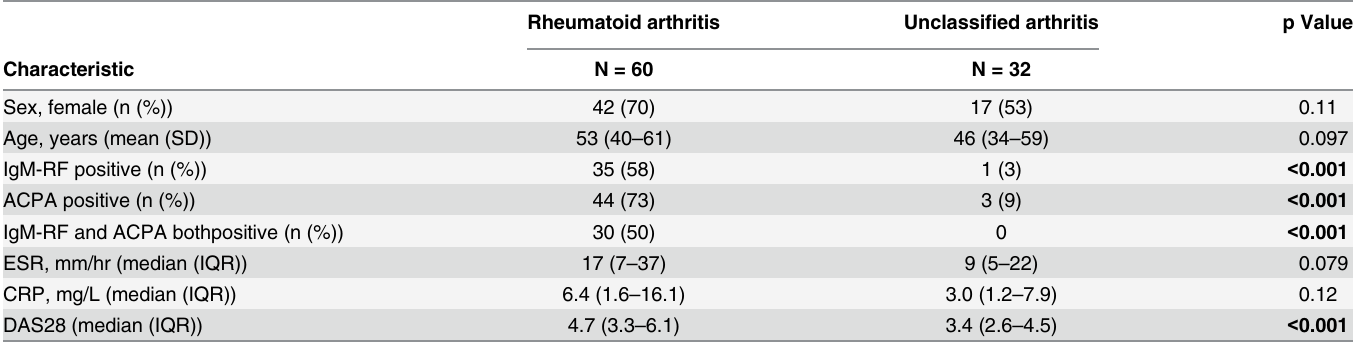
Table 1. Baseline characteristics of early arthritis patients.